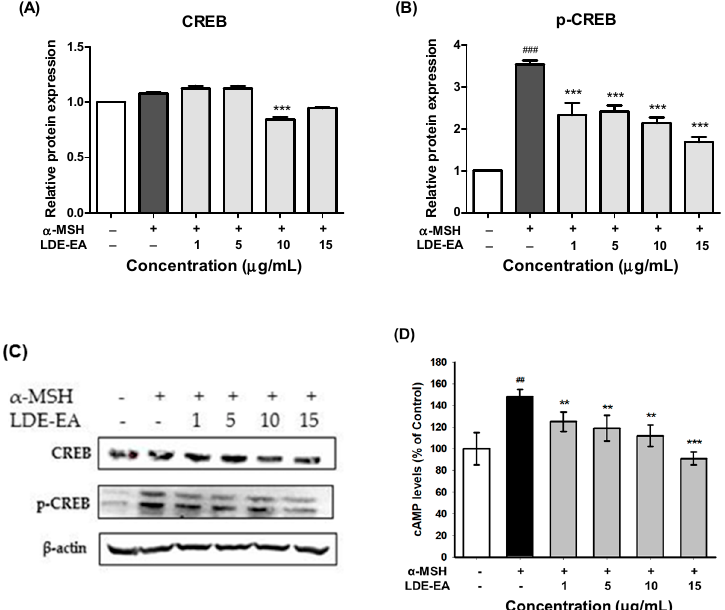
Figure 5. Effects of LDE-EA on protein expression of p-CREB and cAMP levels in B16F10 cells. Cells (1 × 10 5 cells/mL) were cultured for 24 h, and treated with LDE-EA and 200 nM α -MSH for 3 days. After treatment, total cell lysates were assayed by western blot analysis using antibodies for CREB ( A , C ) and p-CREB ( B , C ). Equal amounts of protein loading were checked using β -actin antibodies. ( D ) The total amount of cellular cAMP was assayed using the immunoassay kit. Values are represented as the mean ± SEM of three independent experiments. Note: ### p < 0.001 and ## p < 0.01 compared with the control group; *** p < 0.001 and ** p < 0.01 compared with the α -MSH-treated group.